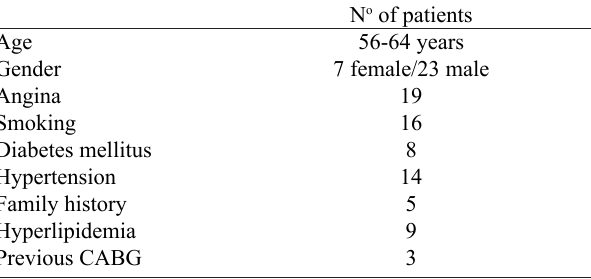
Table 1. Patient